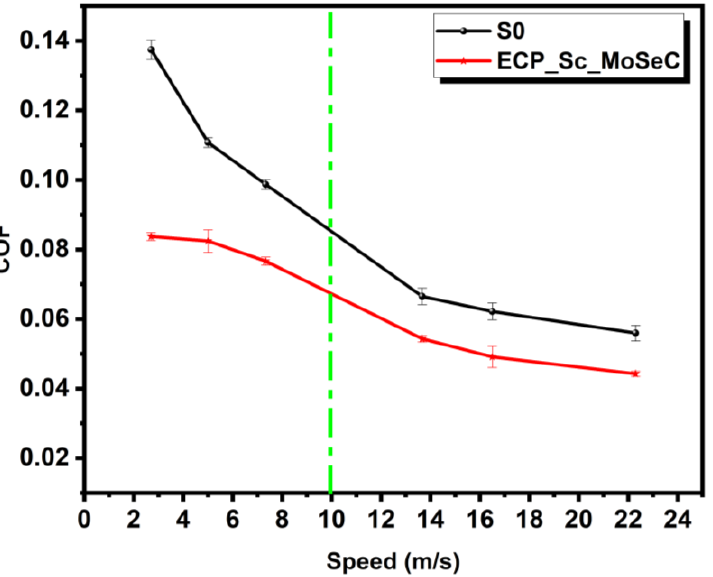
Figure 7. Evolution of the COF with the sliding speed for S0 and ECP_S C _MoSeC specimens (lubri- cated with PAO 8). (lubricated with PAO